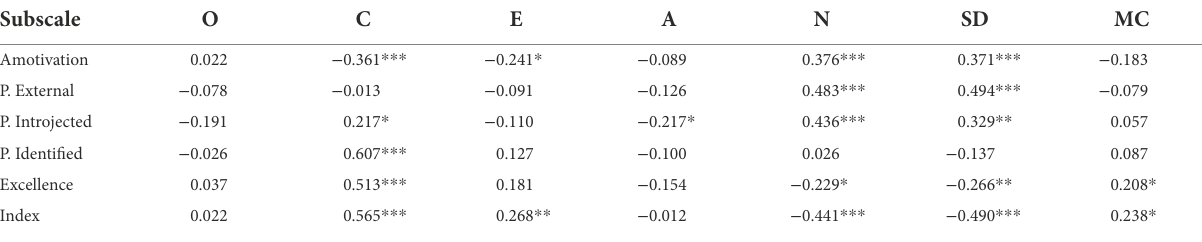
TABLE 7 Correlations between the MPSES and the NEO-FFI-R, Self-Derogation Scale and Social Desirability Scale, Study 1b. Subscale O